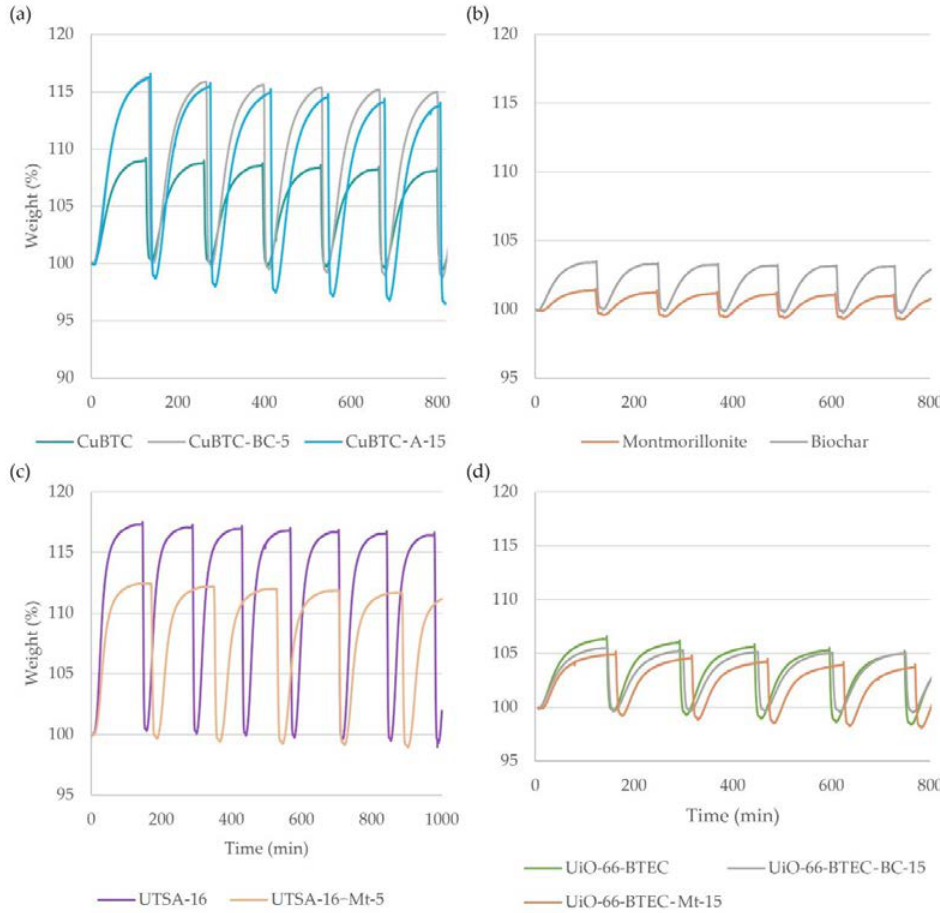
Figure 12. CO 2 adsorption and desorption cycles of MOF-composites: ( a ) CuBTC and its composites containing aerosil (CuBTC-A-15), and biochar (CuBTC-BC-5); ( b ) montmorillonite and biochar; ( c ) UTSA-16 and montmorillonite containing UTSA-16-Mt-5; ( d ) UiO-66-BTEC and its composites containing montmorillonite (UiO-66-BTEC-Mt-15), and biochar (UiO-66-BTEC-BC-15). The adsorption of CO 2 on UTSA-16 and its composites can be considered